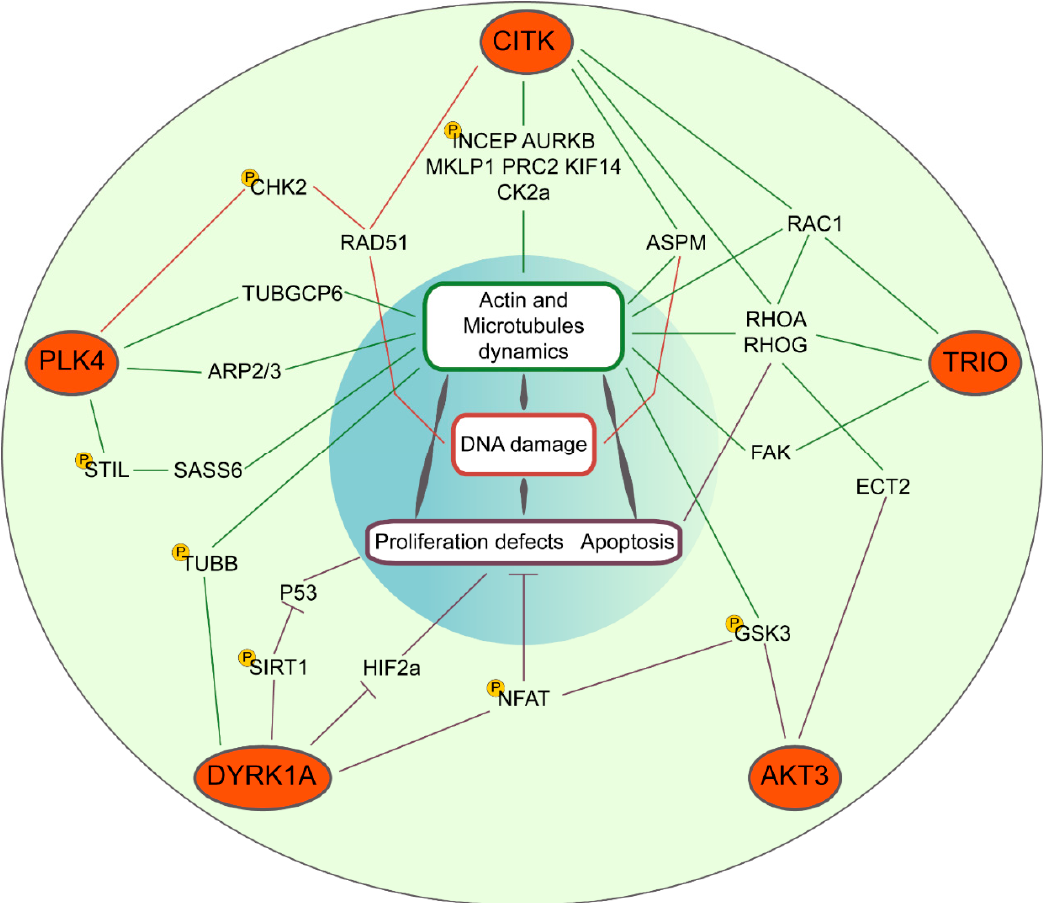
Figure 1. Convergent molecular pathways of microcephaly kinases CITK, PLK4, DYRK1A, AKT3, and TRIO. Their signaling cascades impinge, throughout the indicated common genes, on cytoskeletal dynamics and DNA damage responses or directly on proliferation and apoptosis. The indicated phosphorylation events (yellow P circles) have been experimentally proven.